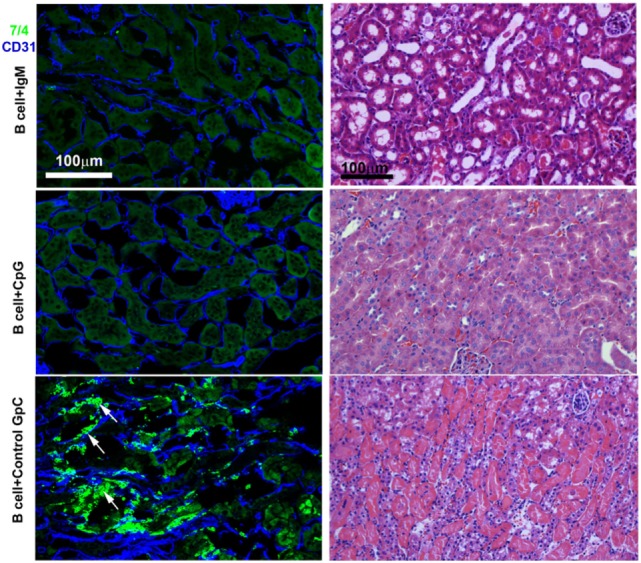
IgM- or CpG ODN-pretreated B cells protect against ischemia-induced renal injury by inhibiting the ischemia-induced inflammatory response (upper two panels). On immunofluorescence staining, note no or minimal 7/4+ inflammatory cell (bright green) infiltration in protected kidneys. CD31+ endothelial cells (blue) are well preserved in protected kidneys. Infusion of B cells pretreated with control GpC ODN failed to protect (bottom panel). Note significant infiltration with 7/4+ inflammatory cells (bright green) many having bilobed nuclei resembling neutrophils (arrows) and damaged CD31+ endothelial cells (blue). The Ly-6B.2 antigen detected by clone 7/4 is expressed on all neutrophils and activated monocytes/macrophages. On H&E-stained histology, note preservation of outer medulla renal tubular histology with minimal interstitial inflammation when mice were infused with IgM- or CpG ODN-pretreated B cells before renal ischemia. There are loss of tubular cells, severe inflammation, and capillary damage with interstitial hemorrhage when mice were infused with B cells pretreated with control GpC ODN. This is a representative example from four separate experiments.